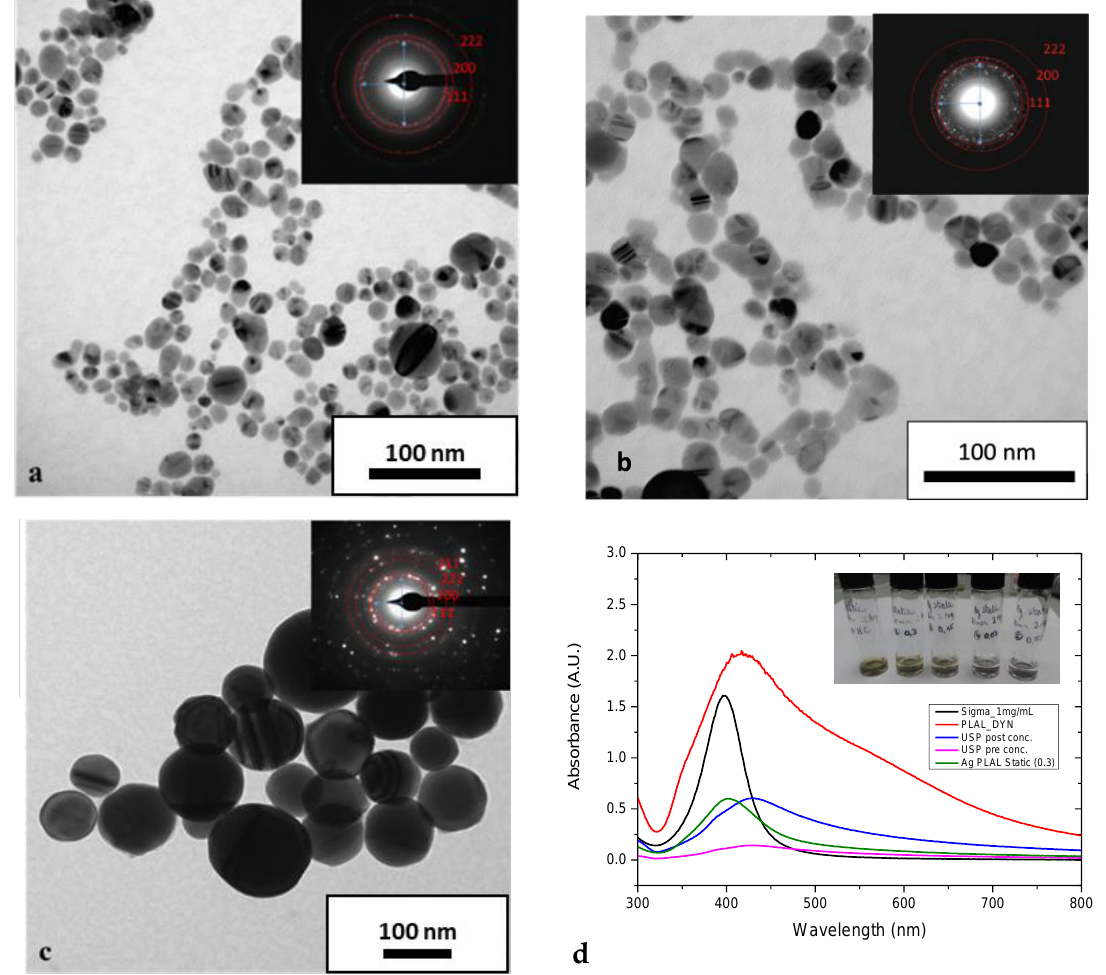
Figure 2. TEM shows typical TEM bright field micrographs and the corresponding selected area diffraction patterns of ( a ) batch LASiS prepared AgNPs, ( b ) recirculatory flow LASiS produced AgNPs and ( c ) USP prepared Ag nanoparticles. ( d ) UV–VIS absorption spectra of AgNPs colloid produced by LASiS Batch recirculatory flow, USP and commercial wet-chemical synthesis, USP post-concentration with rotavapor. LASiS experiments with fPRF = 10 kHz and v = 5 mm s − 1 . The inset shows the AgNPs colloids generated by batch LASiS.